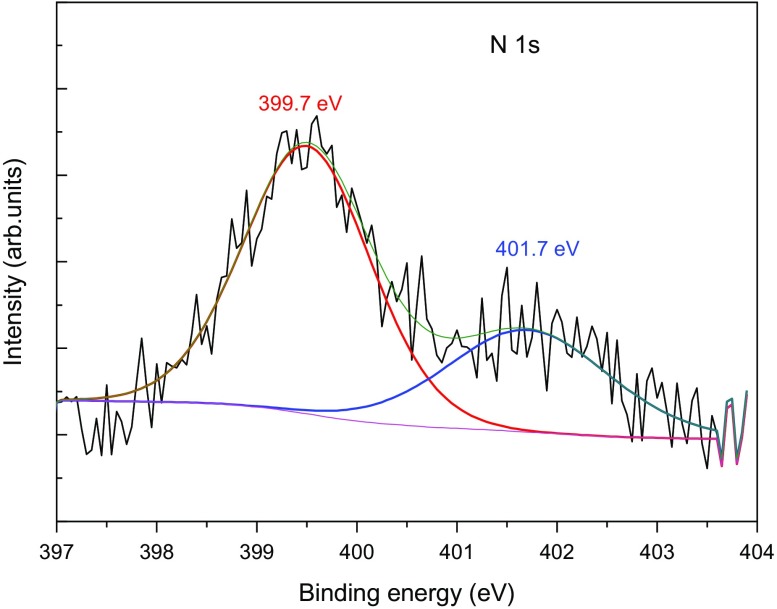
XPS spectrum of N-TiO2 powder.